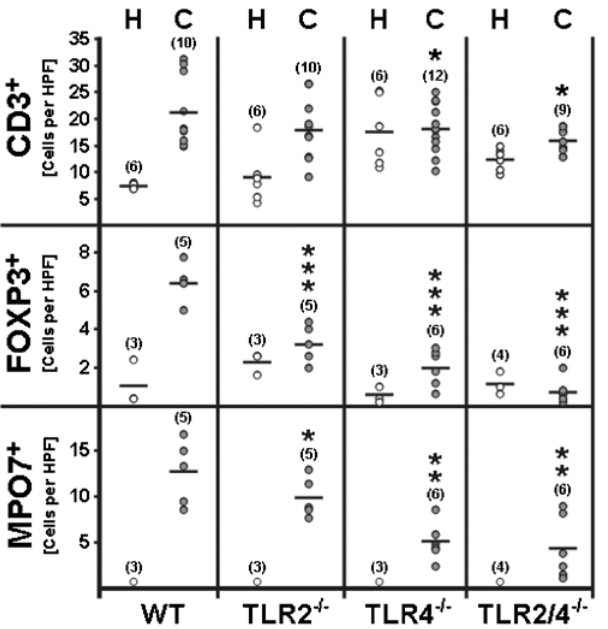
Figure 2. Quantification of immune cells in the colon of DSS-treated mice. Numbers of T-cells, regulatory T-cells, and neutrophils in the colon of DSS-treated wt mice and mice lacking TLR2 and/ or TLR4. The average number of cells positive for CD3, FOXP3, or myeloperoxidase from at least five high power fields (HPF, 400 6 magnification) per animal were determined microscopically in immunostained colon sections of wt mice (WT), and animals lacking TLR2 (TLR2 -/- ), TLR4 -/- (TLR4 -/- ), or both (TLR2/4 -/- ) at day eight after DSS-treatment for seven days (C, grey circles). Healthy animals served as controls (H, white circles). The numbers of analyzed animals are given in parenthesis. Mean values (black bars), and significance levels (as compared to wt animals with colitis) determined by Student’s t-test are indicated ( * , P , 0.05; ** , P , 0.01; *** , P , 0.001).